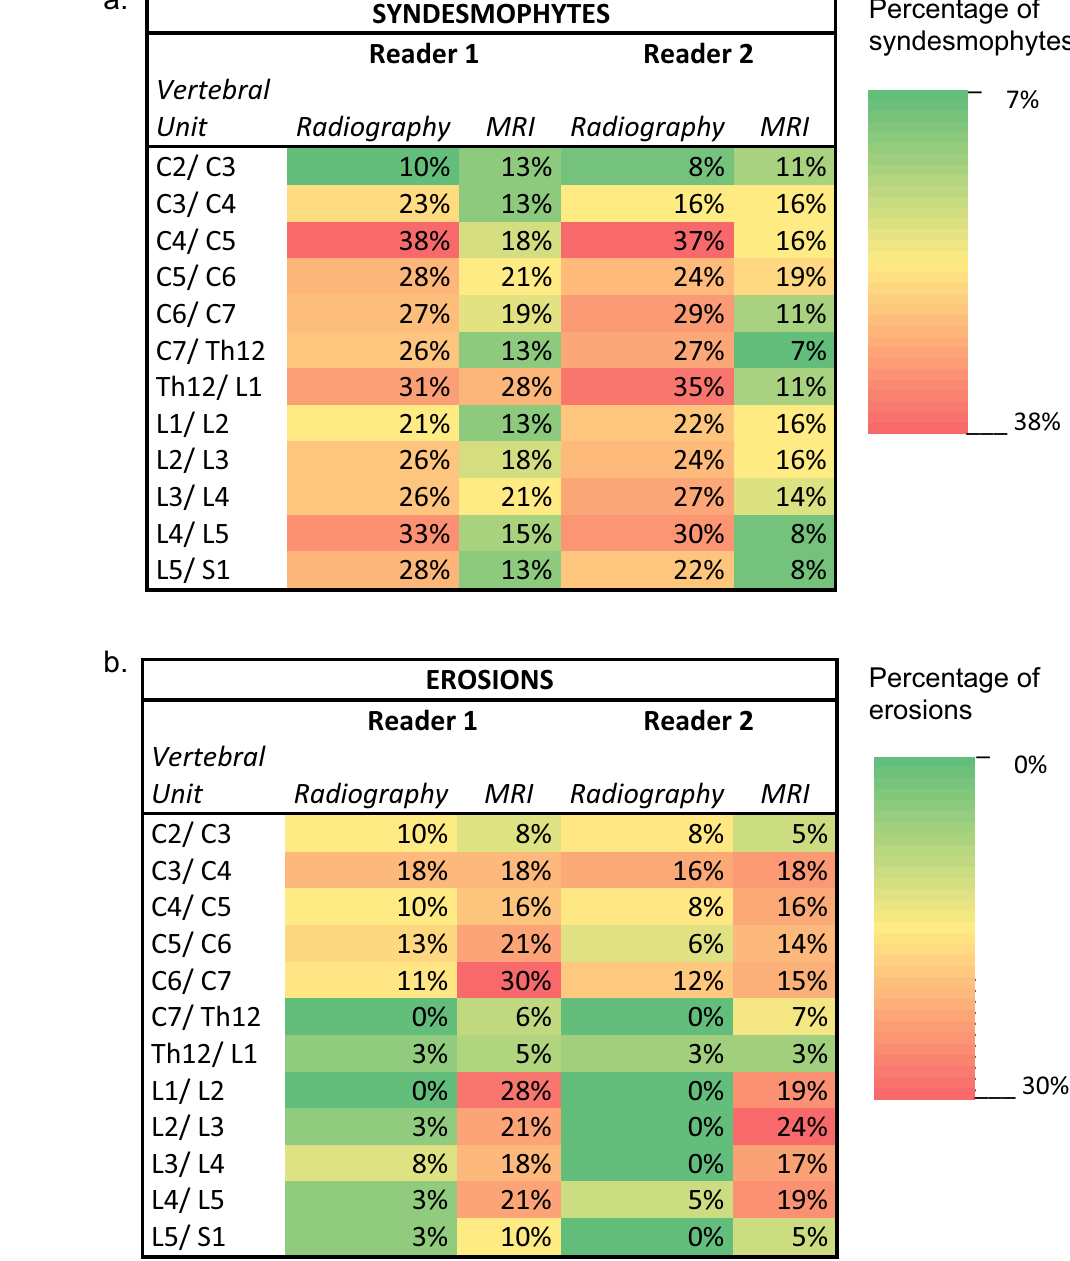
two modalities at the cervical and lumbar vertebral units, with κ values of 0.13 0.10 for the cervical spine and ± 0.03 0.05 for the lumbar spine. ± When analysing the distribution of syndesmophytes at the level of vertebral units radiographically and on MRI,